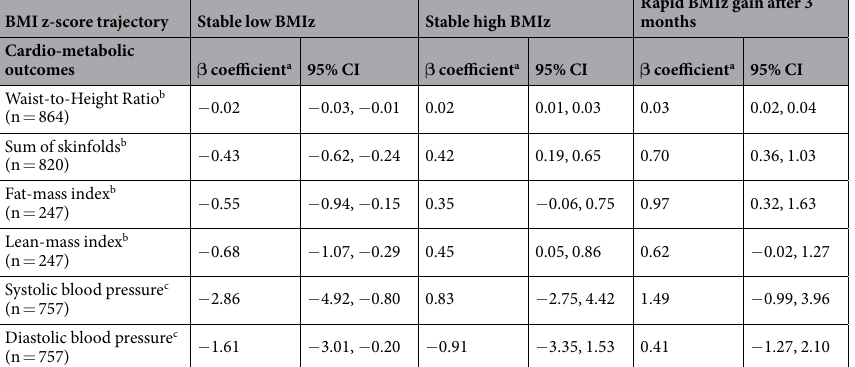
Table 3. Associations between BMI z-score trajectory subgroups with cardio-metabolic outcomes at 5-years. a β -coefficient estimates are referenced to the normal BMI z-score trajectory. b Adjusted for maternal income level, ppBMI, height, GWG, parity, GA at delivery, breastfeeding, child ethnicity, sex and exact age at measurement. c Adjusted for maternal income level, ppBMI, height, GWG, parity, GA at delivery, breastfeeding, blood pressure at 26–28 weeks of gestation, child ethnicity, sex and exact age at measurement.